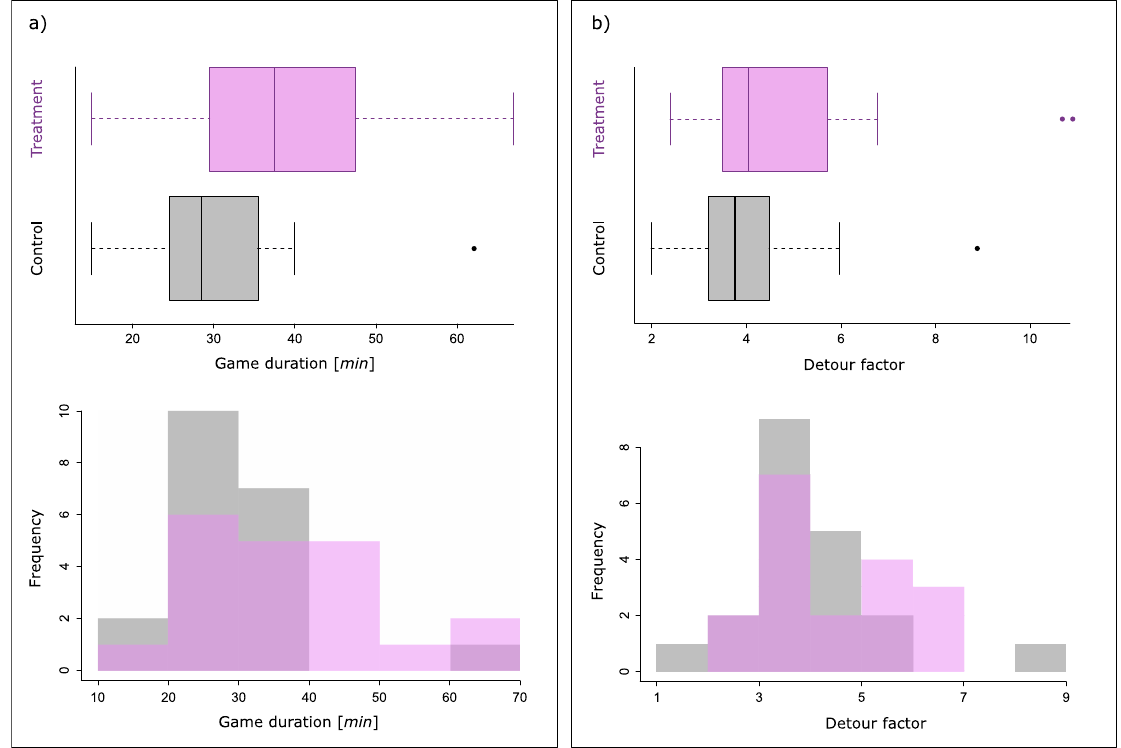
Figure 4. Box plots and histograms of the variables showing significant differences in mean values for the two tested groups. ( a ) Game duration; ( b ) and detour factor. Purple colour represents the treatment group, while grey colour indicates the control